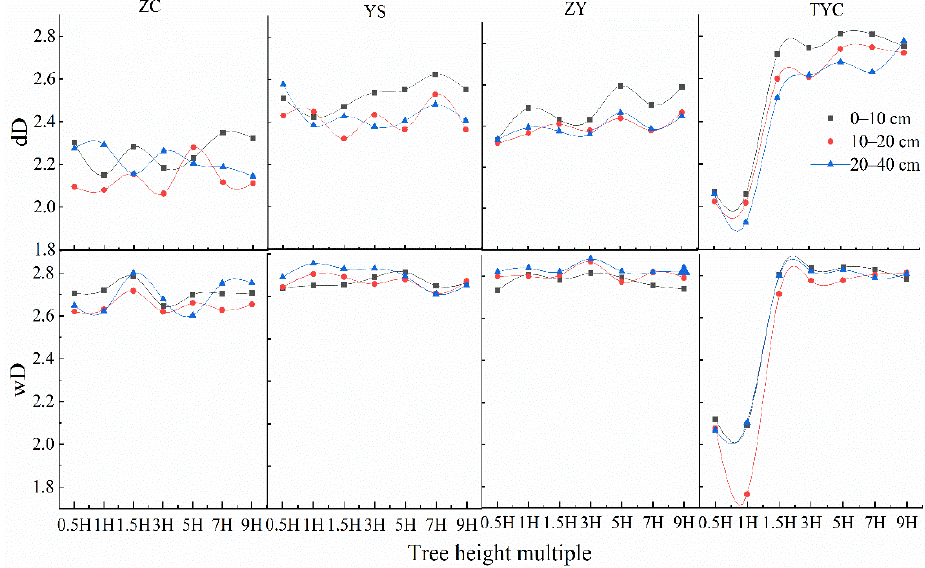
Figure 8. Change in soil fractal dimensions dD and wD at different distances from shelterbelts.